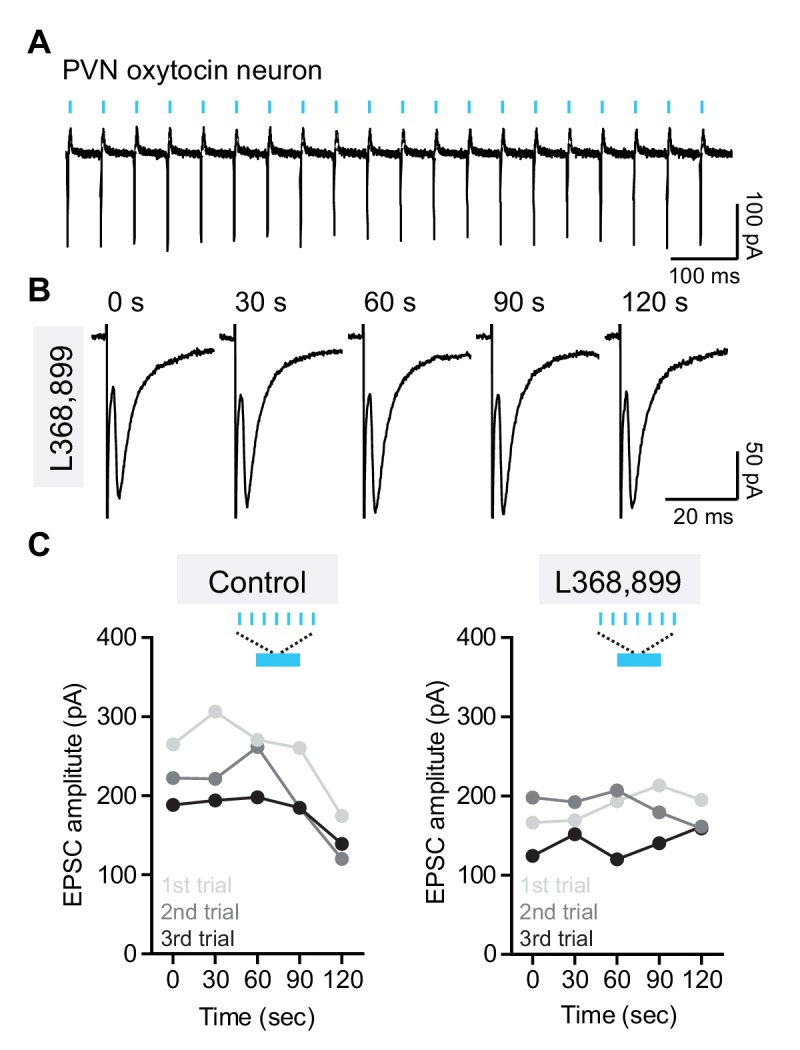
Optical stimulation of oxytocinergic fibers in the VTA modulates evoked EPSCs in DA neurons.(A) Example cell-attached recording trace from one ChR2-positive PVN oxytocinergic neuron in response to 10 ms-long light pulses at 20 Hz delivered in 30 second-long bursts. Blue bars indicate the time of light stimulation. (B) Example evoked EPSC traces from one VTA DA neuron before and after light stimulation in the presence of OxtR antagonist (L368,899). Light stimulation was given between 60 s and 90 s. (C) Left: Example of light stimulation-induced EPSC amplitude changes in three sequential trials from one VTA DA neuron. Inter-trial interval was 6 min. Right: Same as left, but in the presence of OxtR antagonist (L368,899).